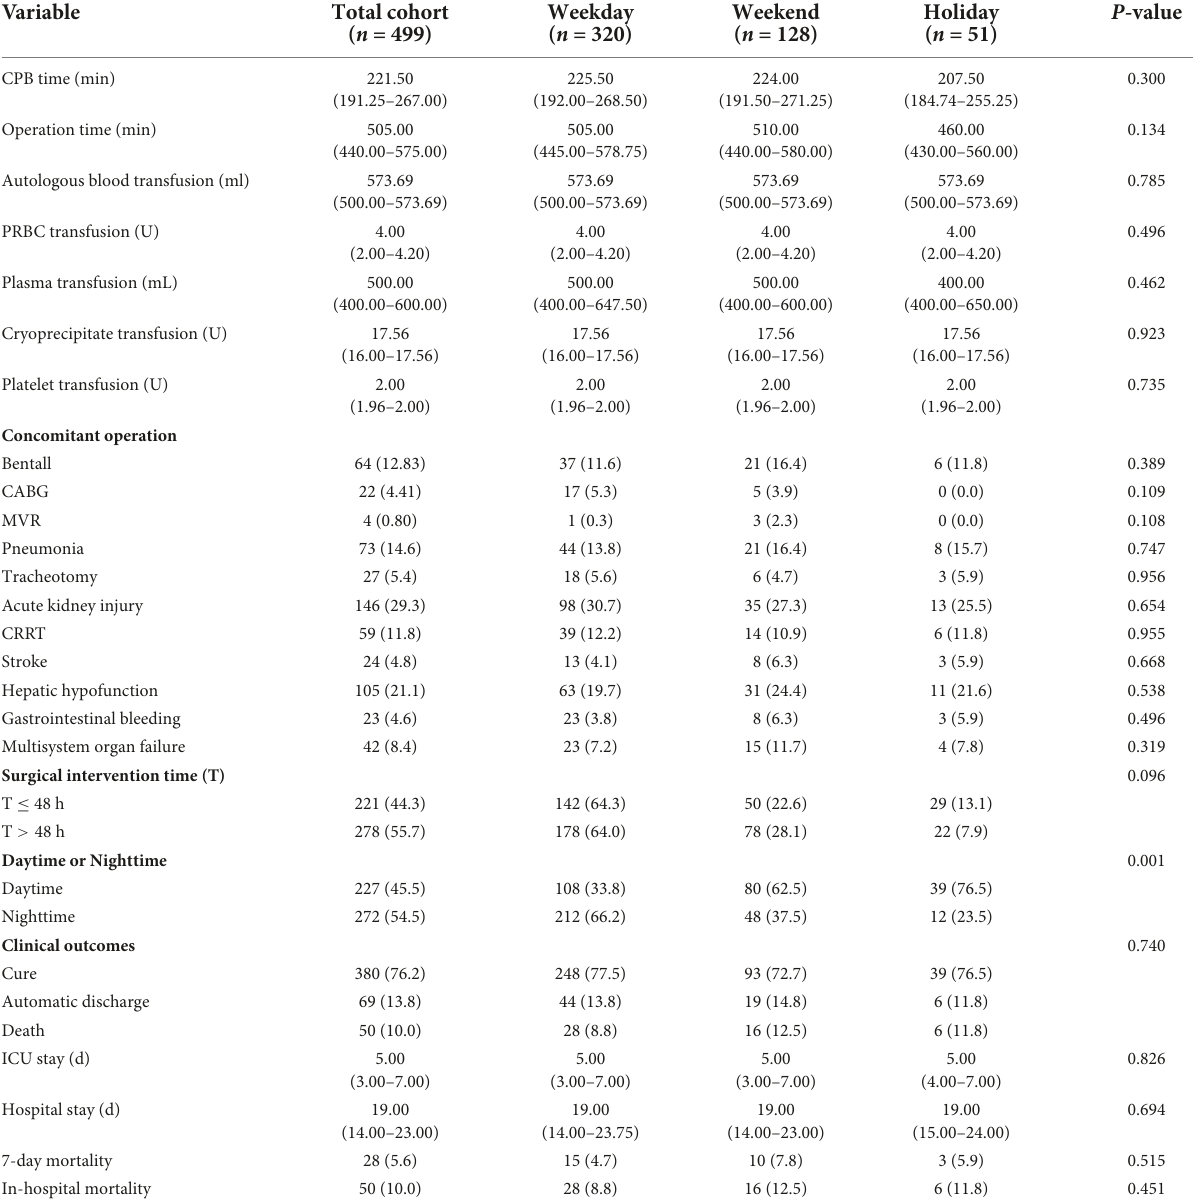
TABLE 2 Intraoperative and postoperative patient characteristics.